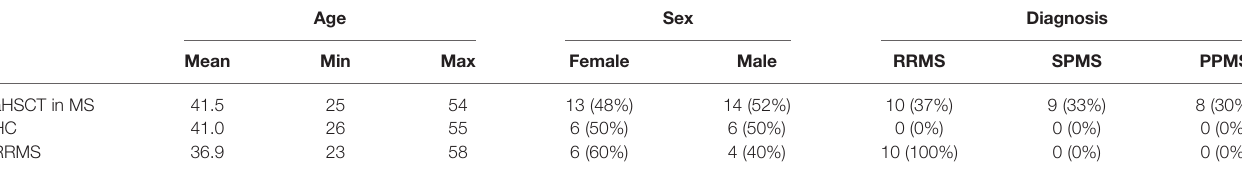
TABLE 2 | Comparison of clinical and demographic characteristics between aHSCT and control groups.